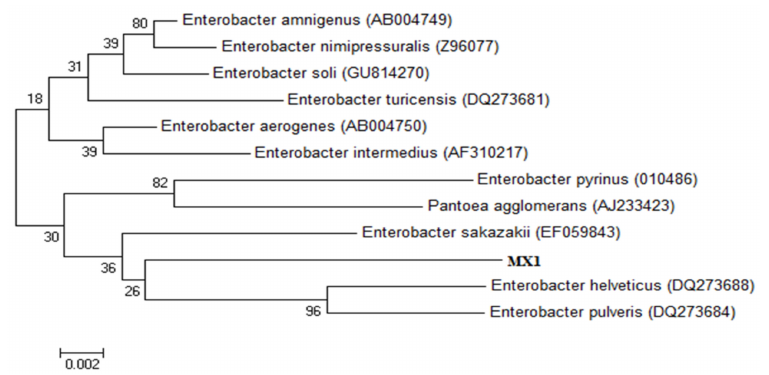
Figure 2. Rootless phylogenetic tree of 16S rDNA sequences between MX1 and related species of model strains in Enterobacter.